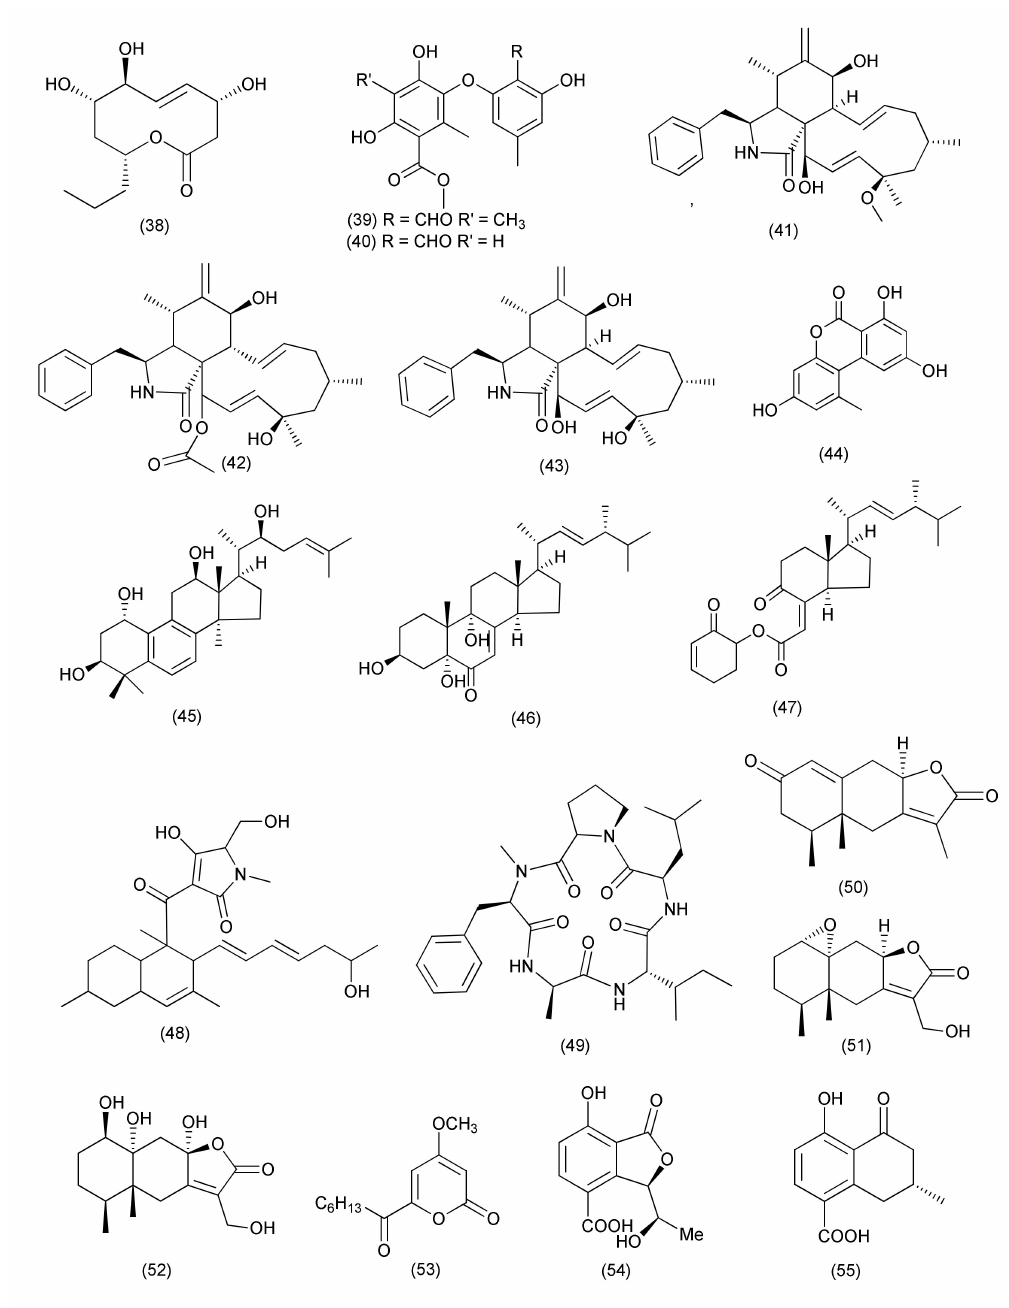
Figure 3. Structures of metabolites 38 – 55 isolated from